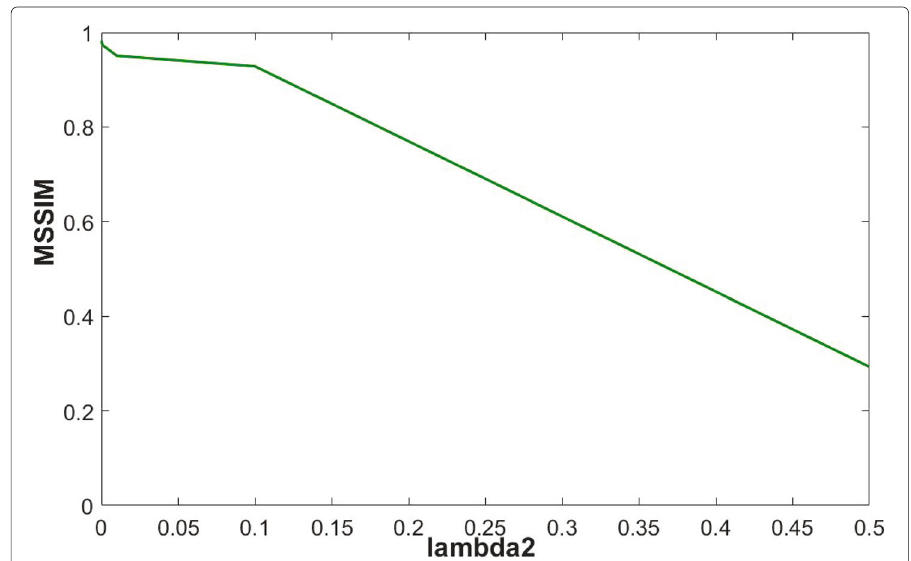
Fig. 9 SSIM of λ 2 in LRTV2++ in parameter